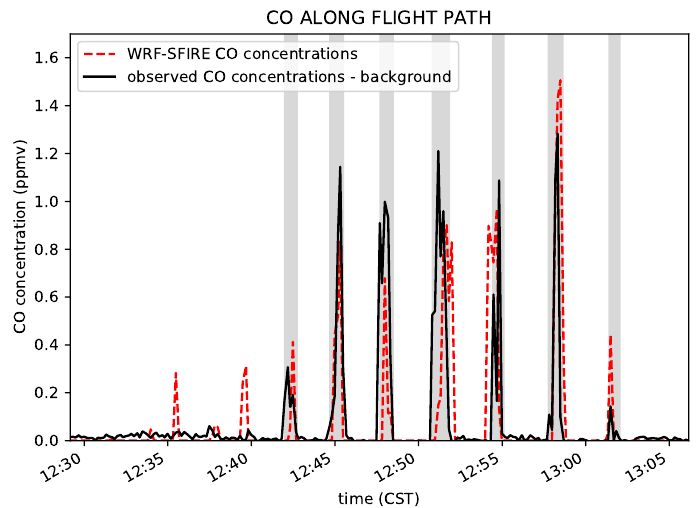
Figure 4. Simulated CO mixing ratio along RxCADRE flight path. Red dashed and solid black lines correspond to LES-derived and observed values, respectively. Gray shading indicates observed smoke time periods (not magnitudes) as identified from CO measurements along the flight